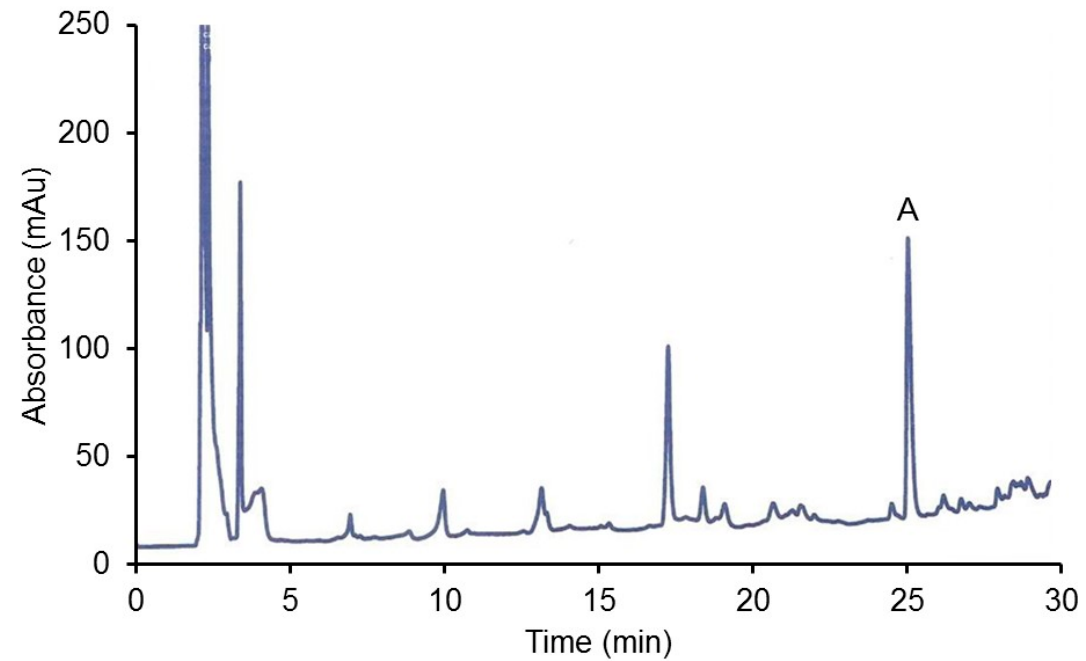
Figure 2. HPLC of liver extract of rat administered catechin (A = methylated catechin).